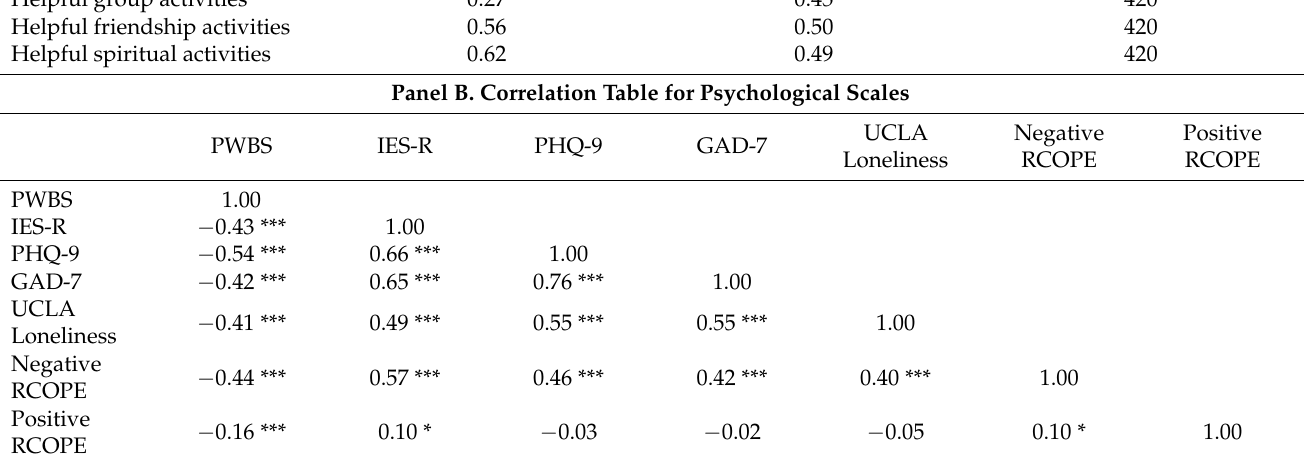
Panel B. Correlation Table for Psychological